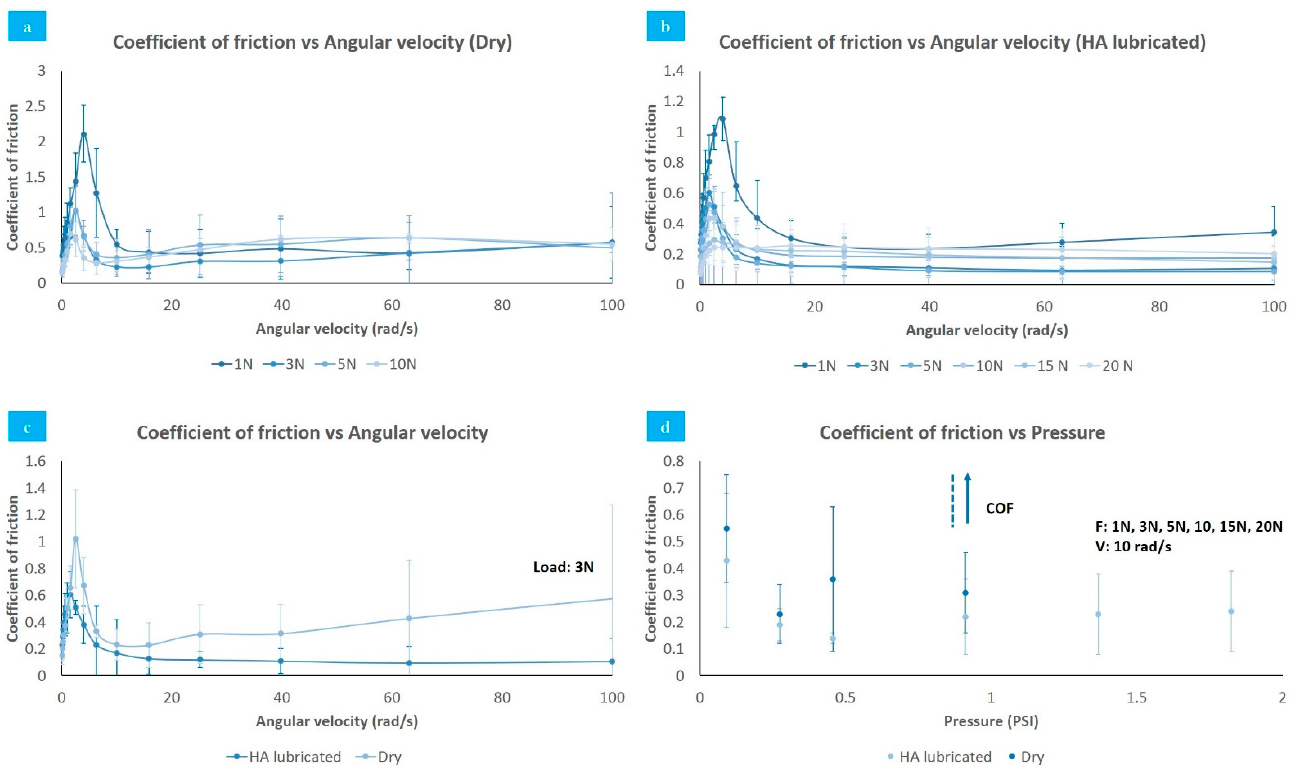
Figure 6. Coefficient of friction vs. angular velocity. ( a ) Dry; ( b ) HA lubricated; ( c ) coefficient of friction vs. angular velocity: Lubrication comparative; ( d ) coefficient of friction vs/pressure (0.1–100 rad/s, 1–20 N).